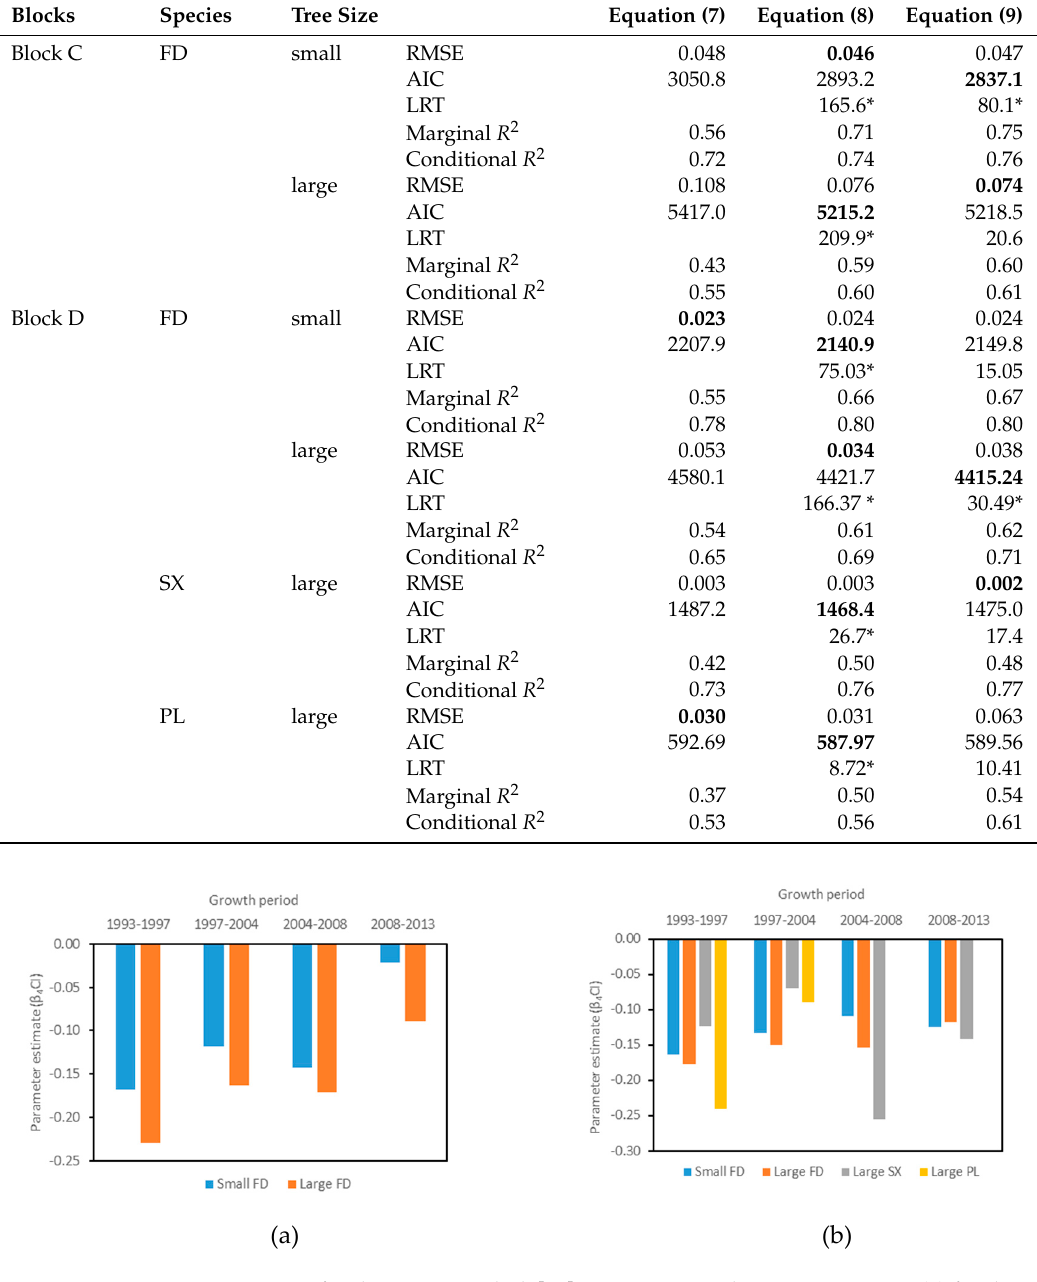
Table 4. Fit statistics for Equation (7) (the base model), Equation (8) (the model with a single competition index), and Equation (9) (the model with a partitioned competition index). FD is interior Douglas-fir; SX is interior spruce; PL is lodgepole pine; “small” are trees from 2.0 to 9.9 cm DBH in 1993; “large” are trees ≥ 10.0 cm DBH in 1993; LRT is the statistic for the likelihood ratio test for comparing the base model and the single CI model; AIC is the Akaike Information Criterion used for comparing the single CI model to the partitioned CI model; RMSE is the root mean square error; Marginal and Conditional R 2 are the pseudo R 2 for the fixed factor alone, and both fixed and random factors, respectively; and * indicates where the LRT was significant at α = 0.05. The smallest AIC and RMSE for a species group and block are shown in bold.